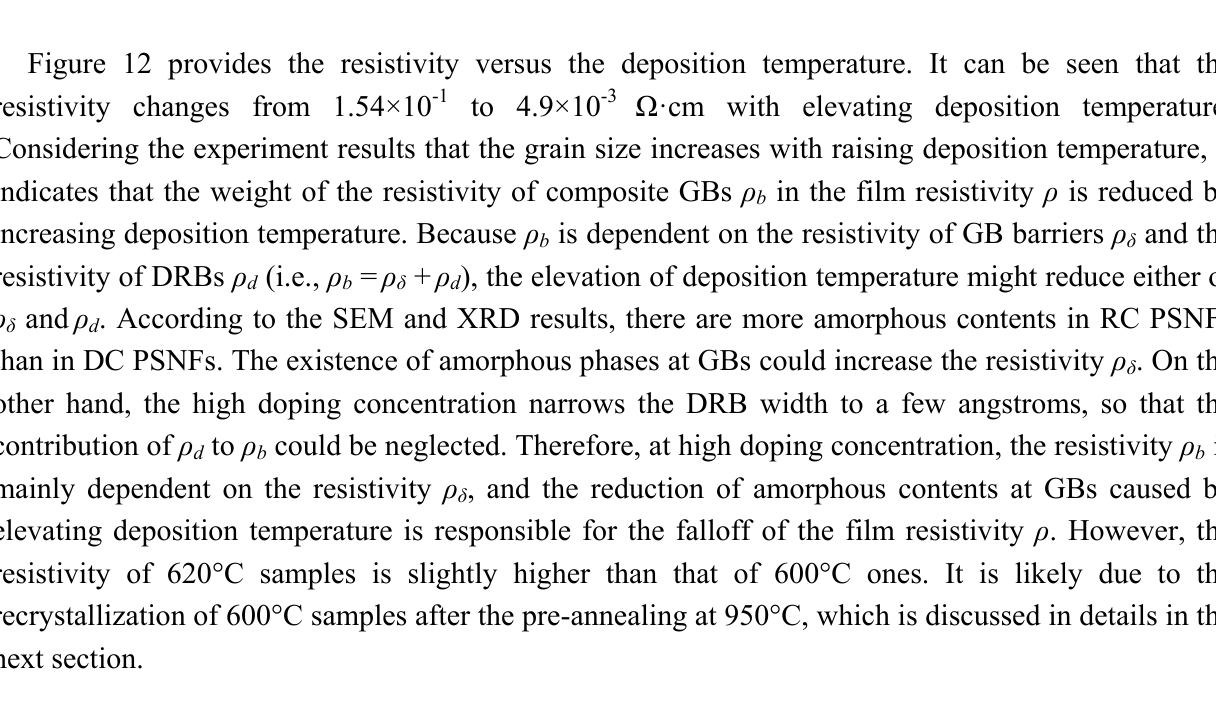
Figure 12. Resistivity of boron doped PSNFs versus deposition